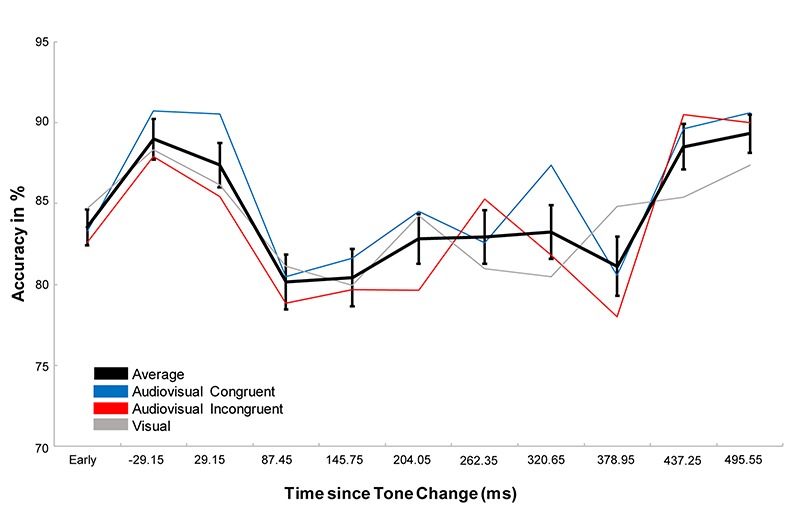
Representation of the effect of time. The black line represents the average over all conditions, the blue and red line the congruent and incongruent conditions respectively and the gray line the visual control. Error bars display the standard error of the mean. While the accuracy after the tone change initially increases, accuracy starts to drop between 58.3 and 116.6 ms after the tone change and stay lower than during the early window until about 466.1–524.7 ms after the tone change. While the accuracy drop is significant against the accuracy directly after the tone change, neither the initial increase, nor the following drop and recovery is significant against the early baseline window. Interestingly, one can observe stronger increases and reduced drops in the audiovisual congruent conditions, but the effect is not significant.